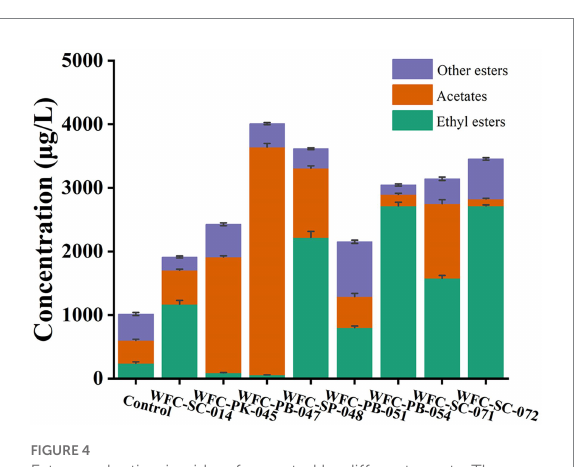
FIGURE 4 Ester production in ciders fermented by different yeasts. The orange bar indicates average acetate concentration, the green bar represents ethyl esters, and the purple bar shows other esters. All eight strains had outstanding ester production capacity to improve cider sensory